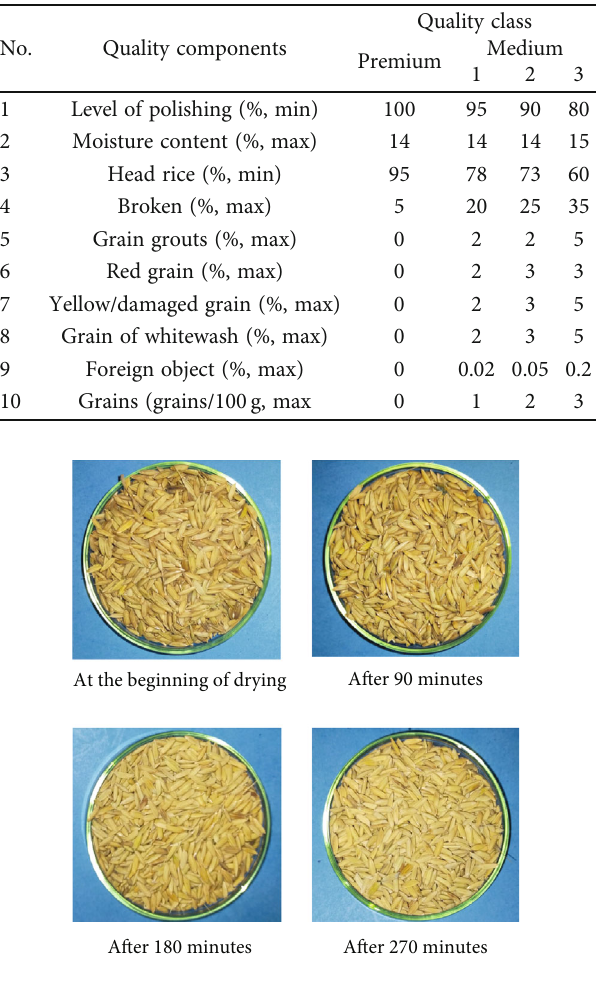
Figure 15: Color of the paddy grain samples after successive drying time